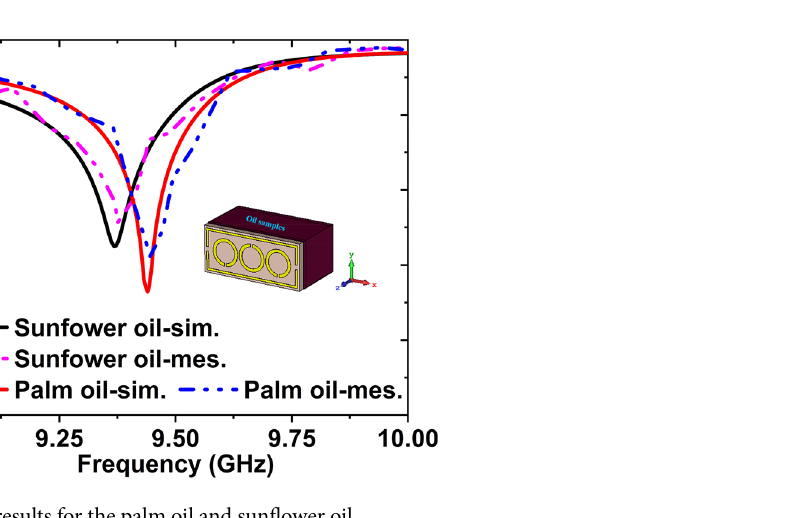
Figure 21. S 11 results for the palm oil and sunflower